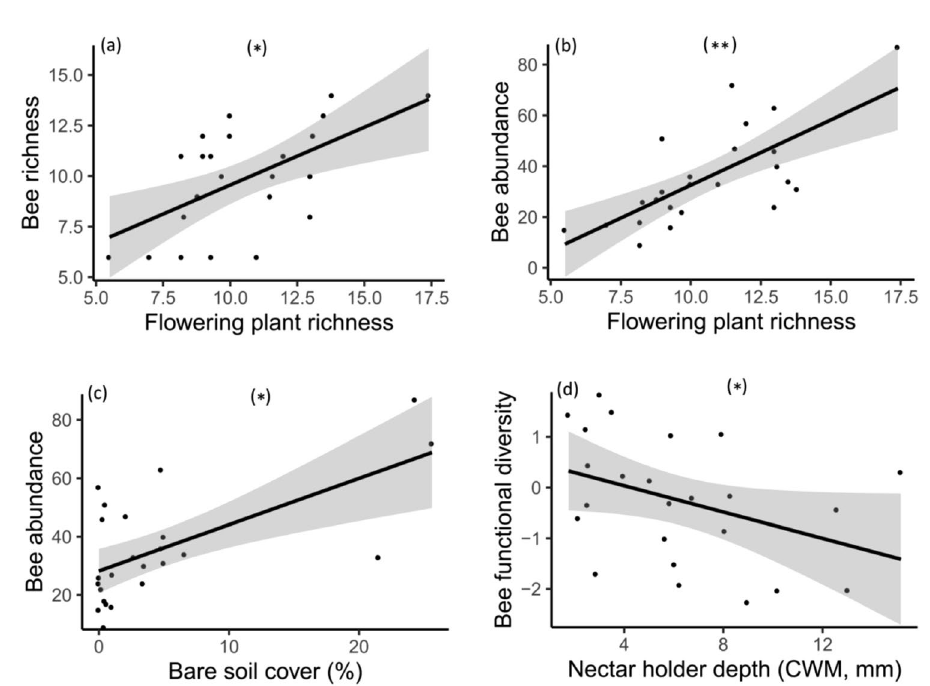
Figure 1. Relationships between ( a ) bee species richness and flowering plant species richness, ( b ) bee abundance and flowering plant species richness, ( c ) bee abundance and bare soil cover, ( d ) bee functional diversity and nectar holder depth. Plotted lines show the predicted relationship and shaded areas indicate the 95% confidence intervals: * P ≤ 0.05; ** P ≤